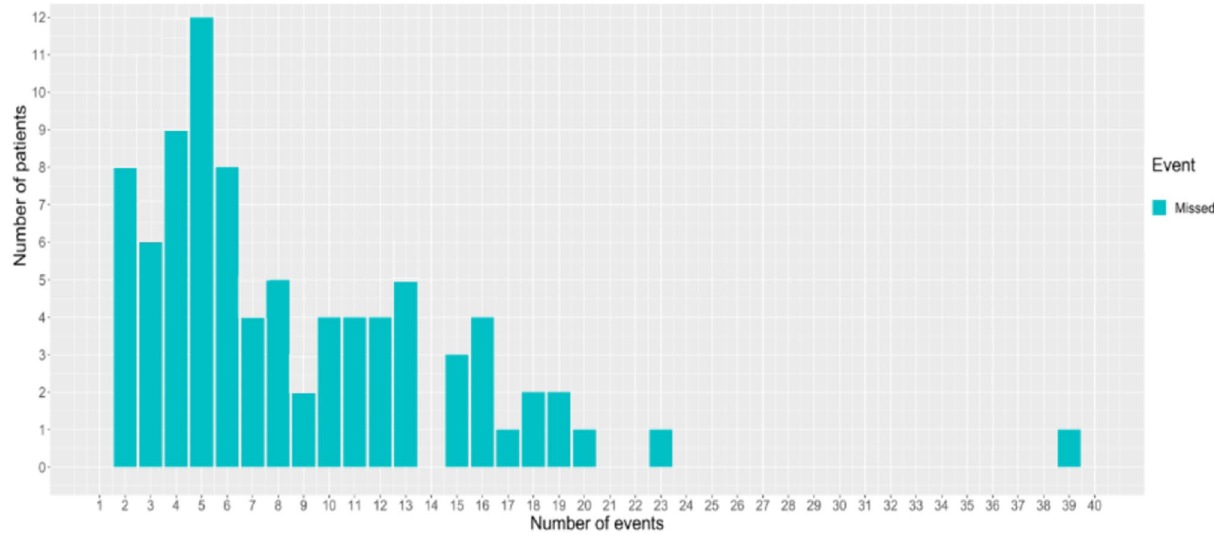
Figure 2. Histogram of oxygen saturation missed events. Missed events were concentrated in select